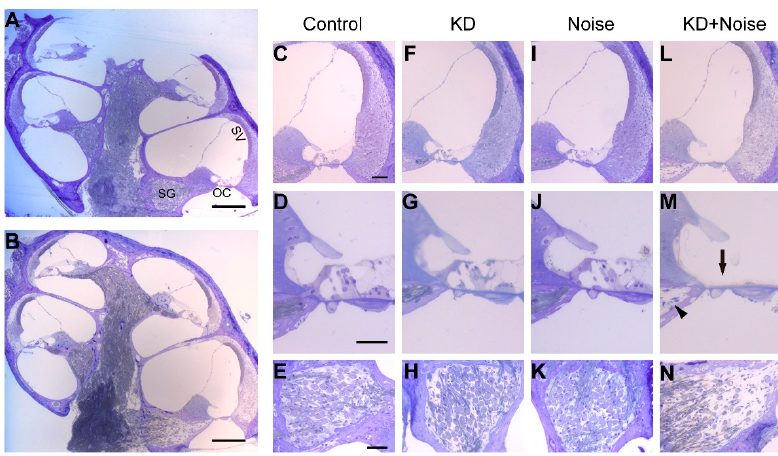
Figure 4. Cochlear morphology of the basal turn in control, KD, noise and KN groups. A full view of a cochlea obtained from noise ( A ) and KN groups ( B ); Panels C , F , I and L show the morphology of the cochleae at the basal turn in control and experimental groups; Panels D , G , J and M show the morphology of the magnified OC in panels C , F , I and L , respectively; Panels E , H , K and N show the SGN at the basal turn in the different groups. Abbreviations: SV: stria vascularis; OC: organ of Corti; SG: spiral ganglia. The scale in panel represents 200 µ m, and scales in panel C , D and E represent approximately 40 µ m.